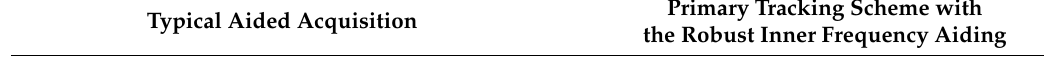
Table 4. Hardware resource utilization.